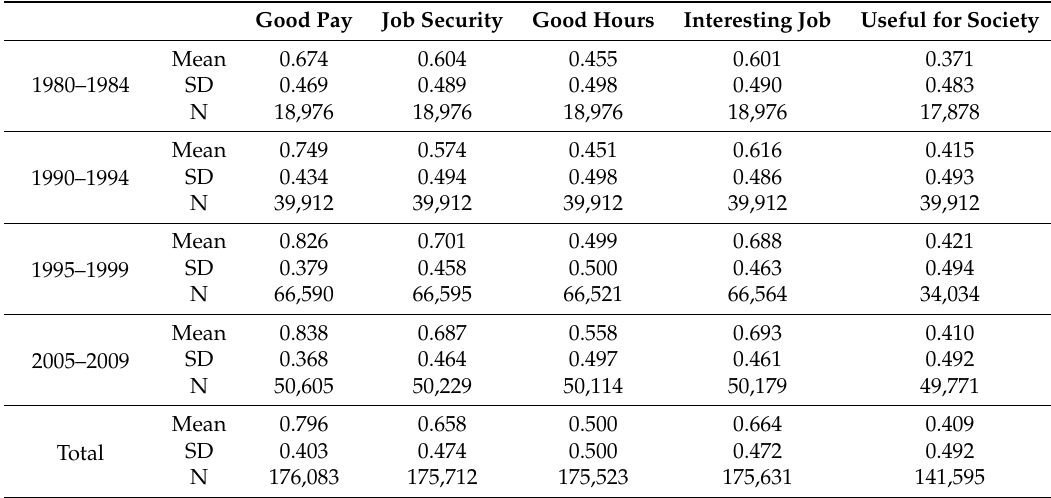
Table 2. Number of observations and the average of work values by period. Good Pay Job Security Good Hours Interesting